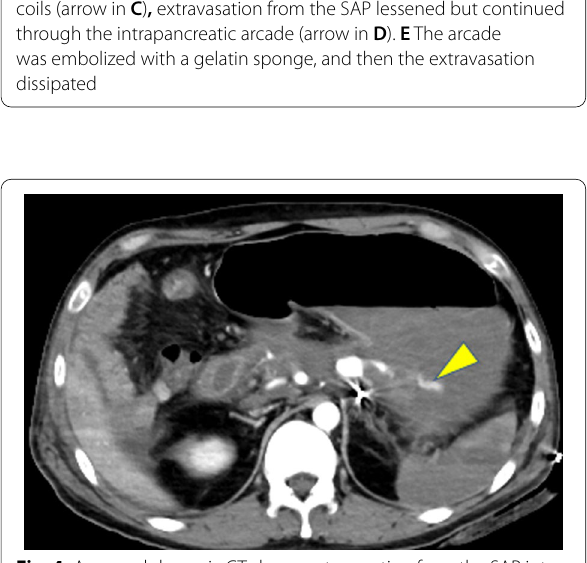
Fig. 4 A second dynamic CT shows extravasation from the SAP into the stomach